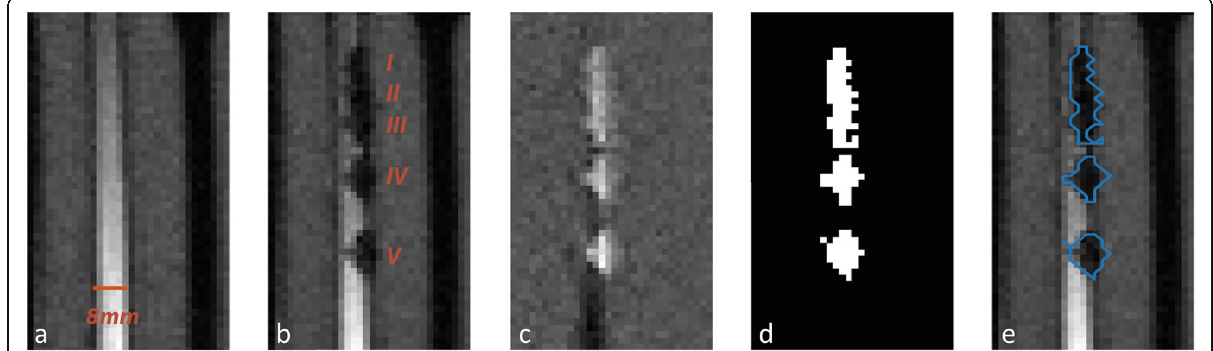
Fig. 2 Segmentation of the artifact from a sagittal gradient echo image with 6.25 mg/mL iron(II,III)oxide markers (echo time 2.48 ms, slice thickness 5 mm, phase encoding direction: parallel). a Reference image of the 8-mm vessel without guidewire. b Marker image with inserted guidewire. c Result after subtraction of marker image from reference image. d Mask image with segmented markers used to calculate mean artifact width. e Outline of segmented markers overlaid on the marker